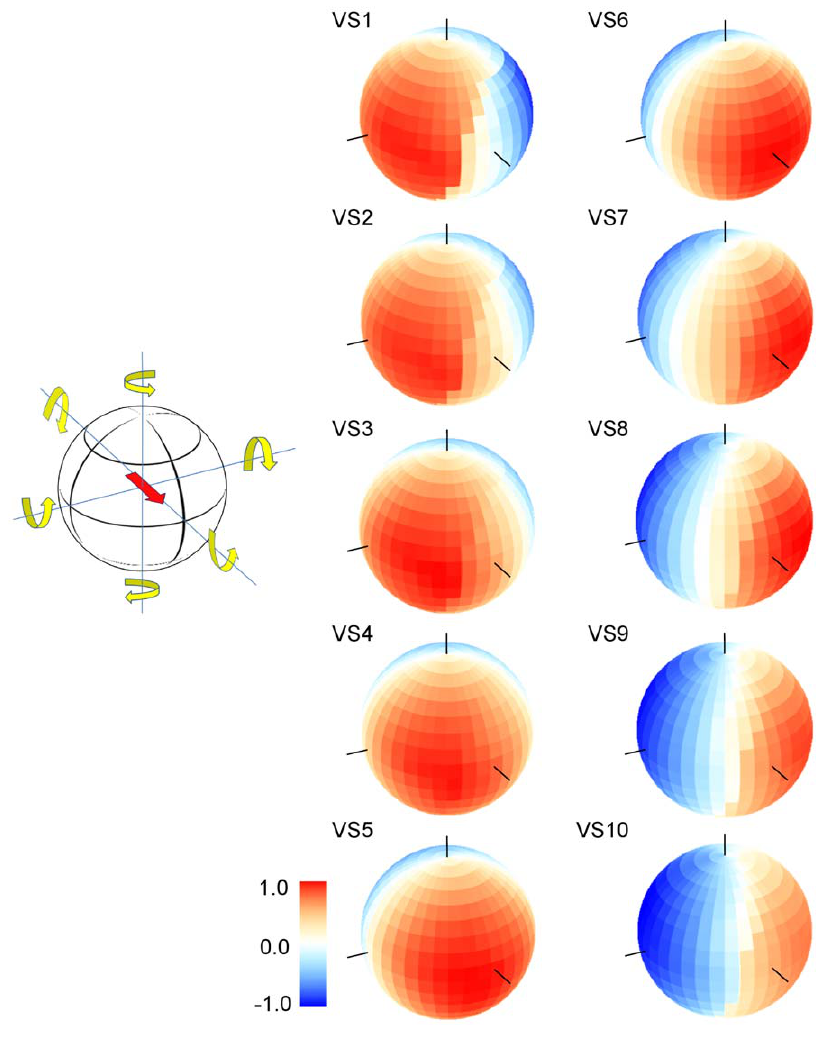
Figure 6. Rotational action fields for all VS-cells, shown in false color code. The orientation of the sphere and the definition of rotation are indicated to the left. The red arrow indicates the viewing direction of the fly. Responses were normalized for each cell to their maximum. The black lines on the spheres indicate the location of the roll, pitch, and yaw axis.